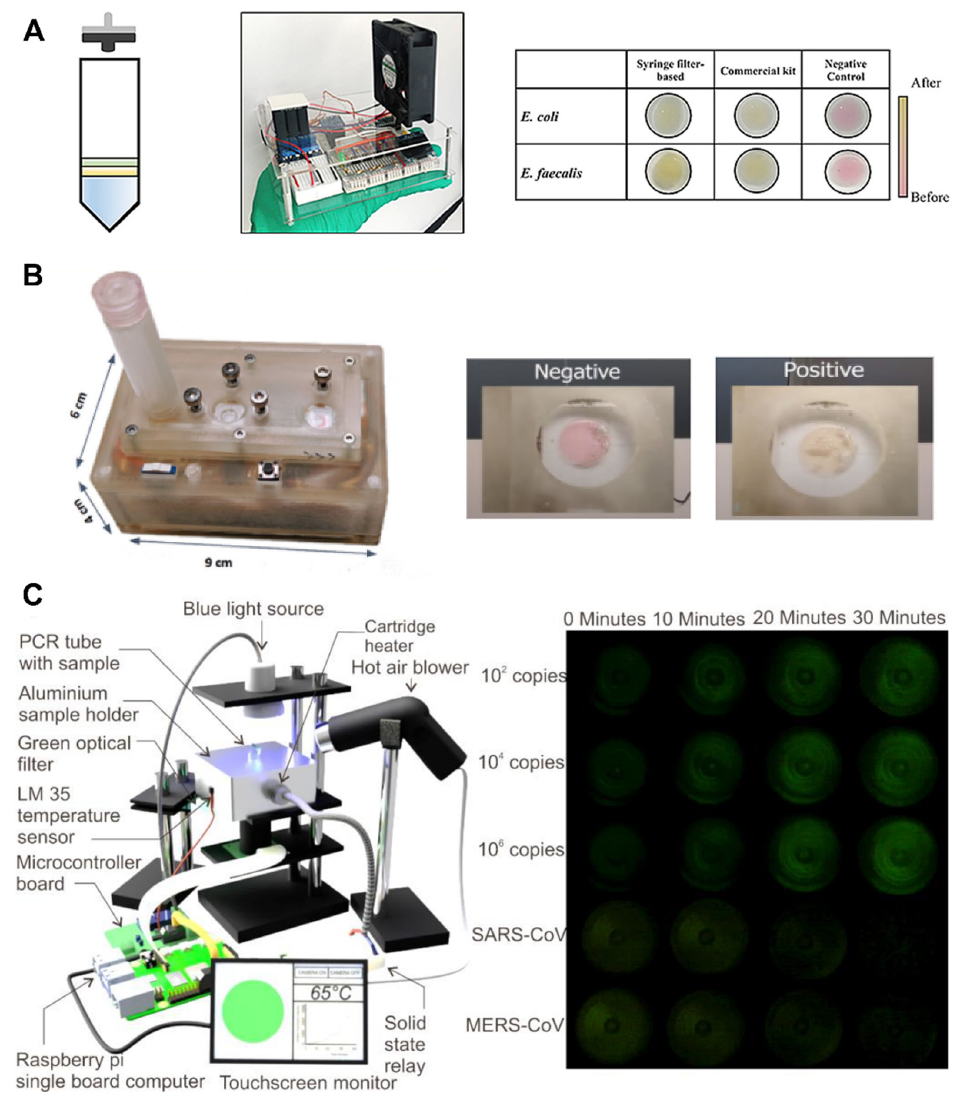
Figure 6. LAMP devices in recent research. ( A ) Lee et al.’s portable LAMP device. Reprinted with